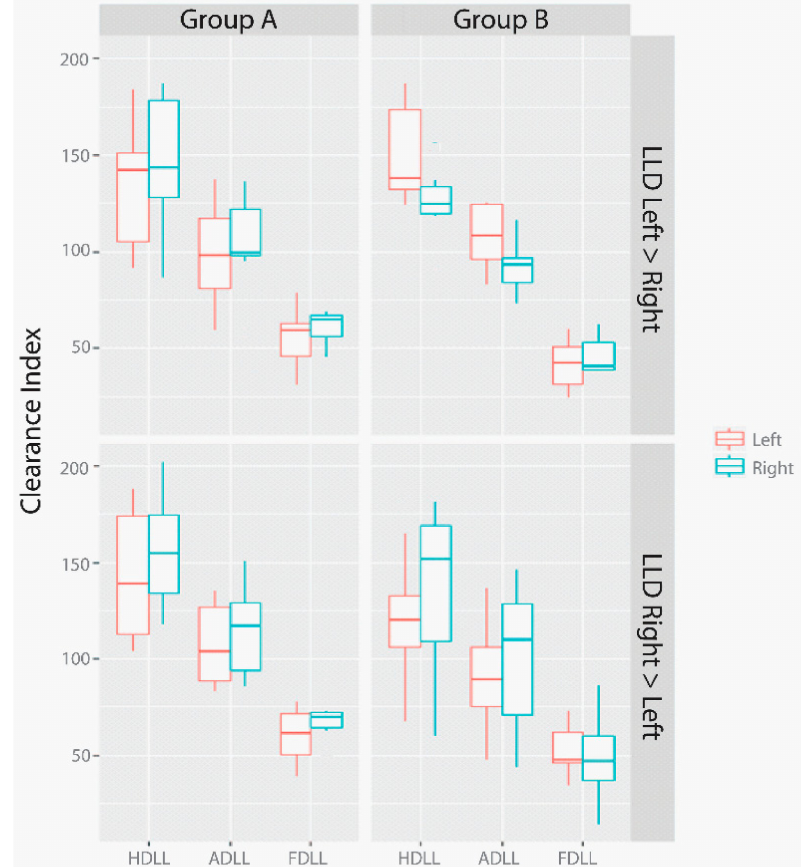
Figure 5. The differences between maximal DLLs throughout the stance phase and the contralateral minimal DLLs throughout the swing phase in both groups, classified according to anatomic